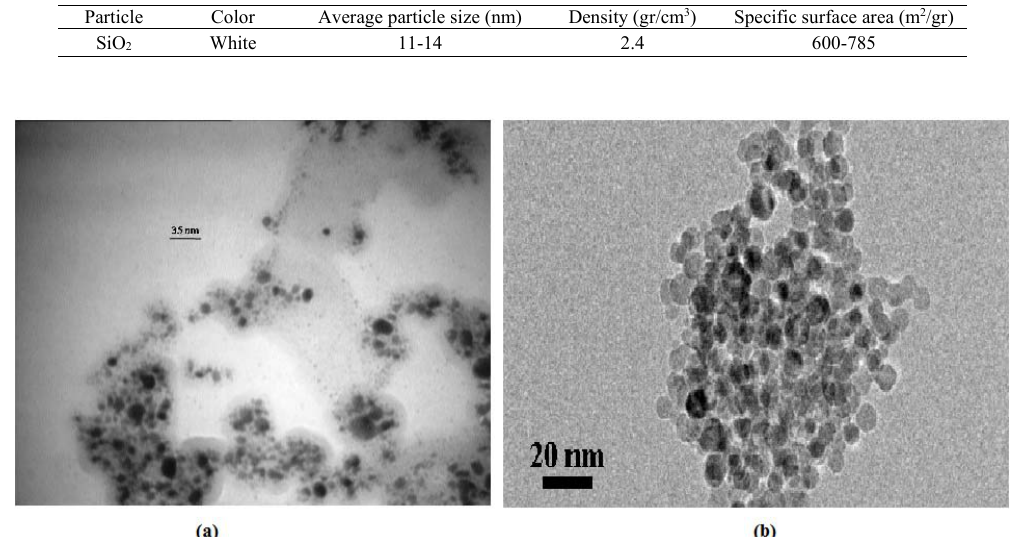
Fig. 1. (a) TEM and (b) SEM image of silica